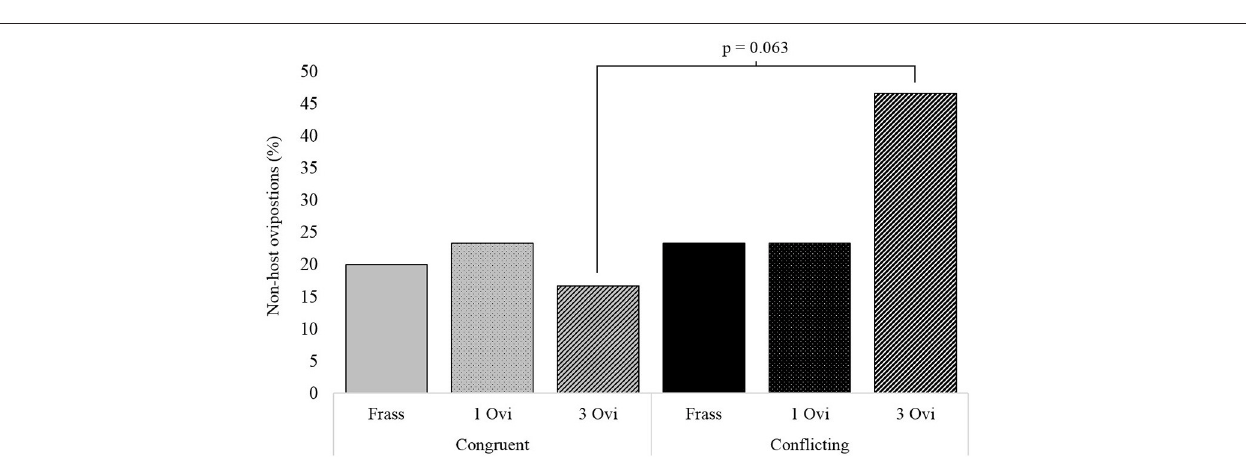
FIGURE 5 | The percentage of wasps oviposting in non-host when given either conflicting or congruent experience with either a 20s frass experience (Frass), a single oviposition (1 Ovi), or 3 spaced ovipositions (3 Ovi) ( n =